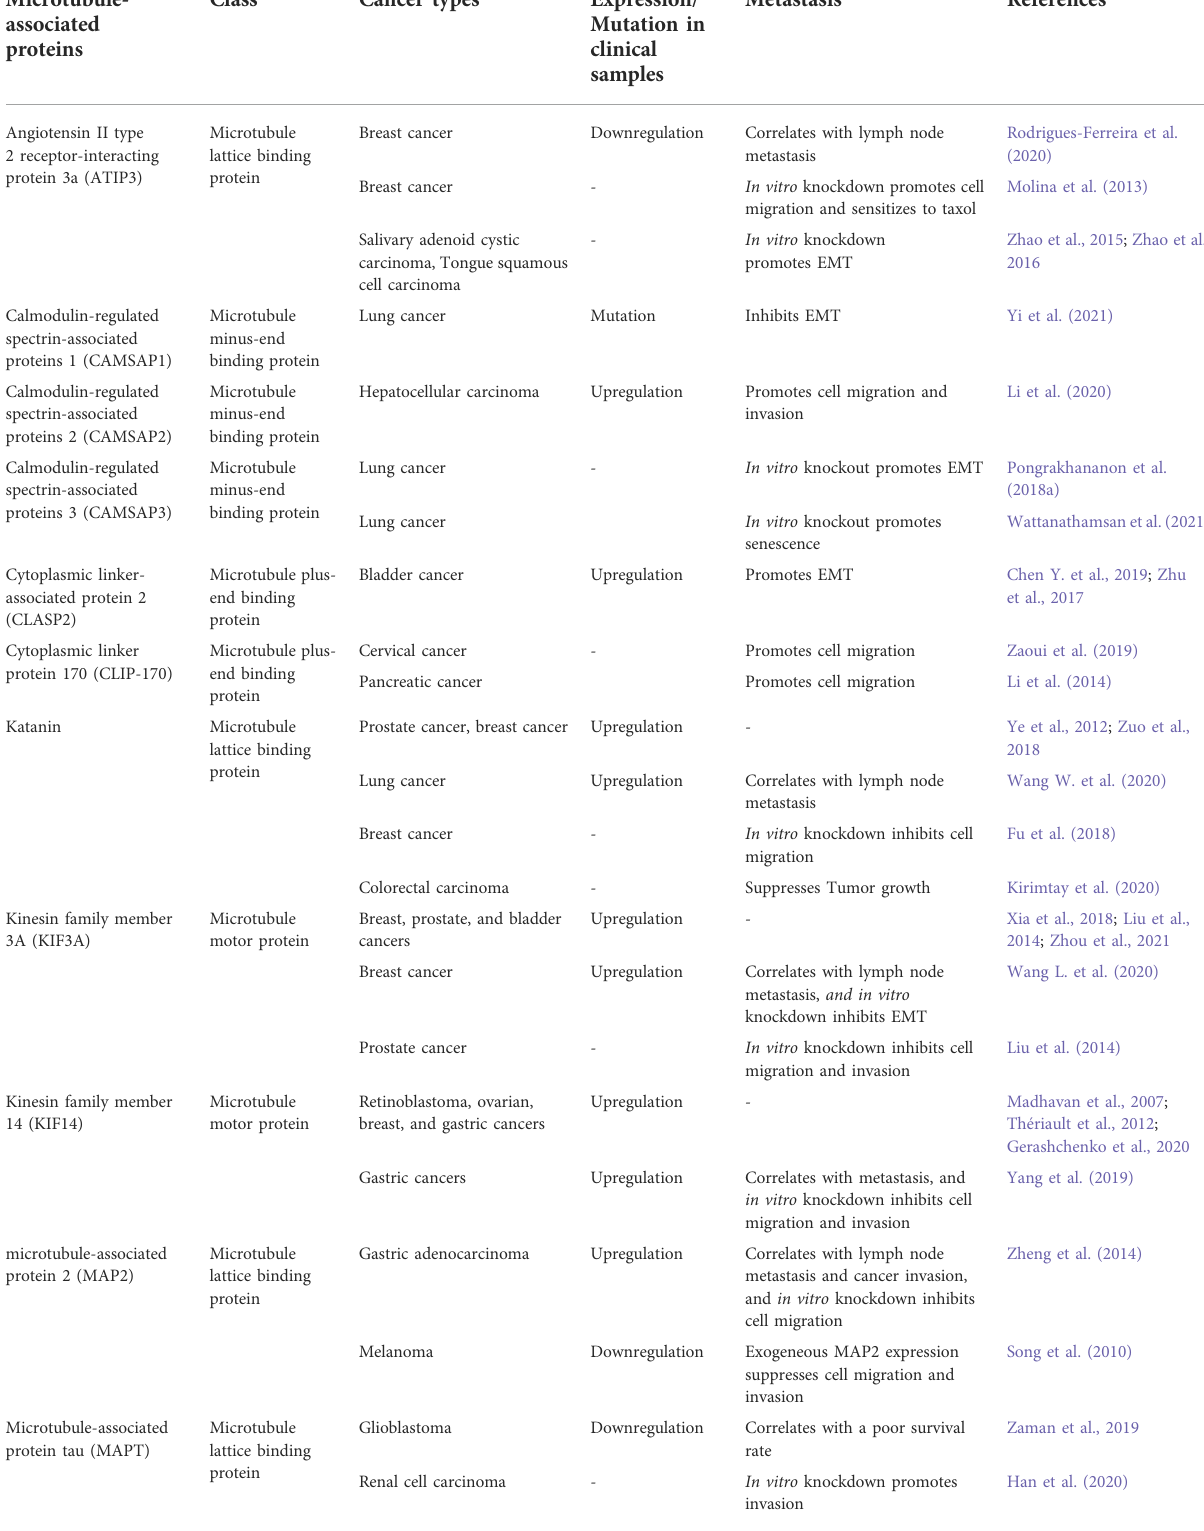
TABLE 1 List of microtubule-associated proteins and recent evidence in